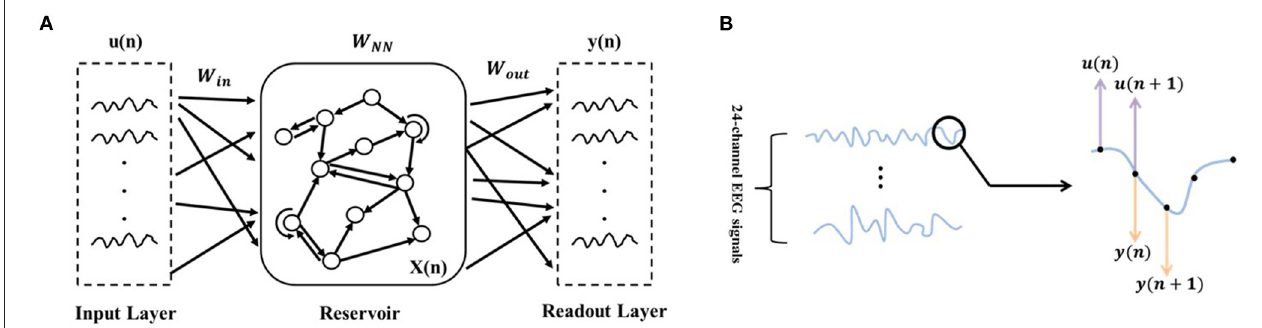
FIGURE 3 | ESN schematic diagram. (A) Network structure diagram. (B) Illustration of the input and output data selection based on the time series of EEG signals. u( · ) refers to the input data and y( · ) refers to the output data.